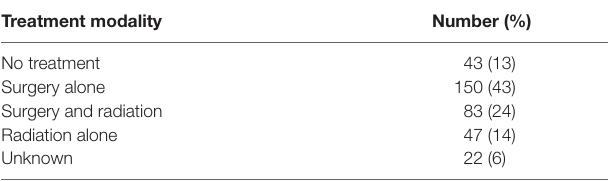
TaBle 1 | Treatment